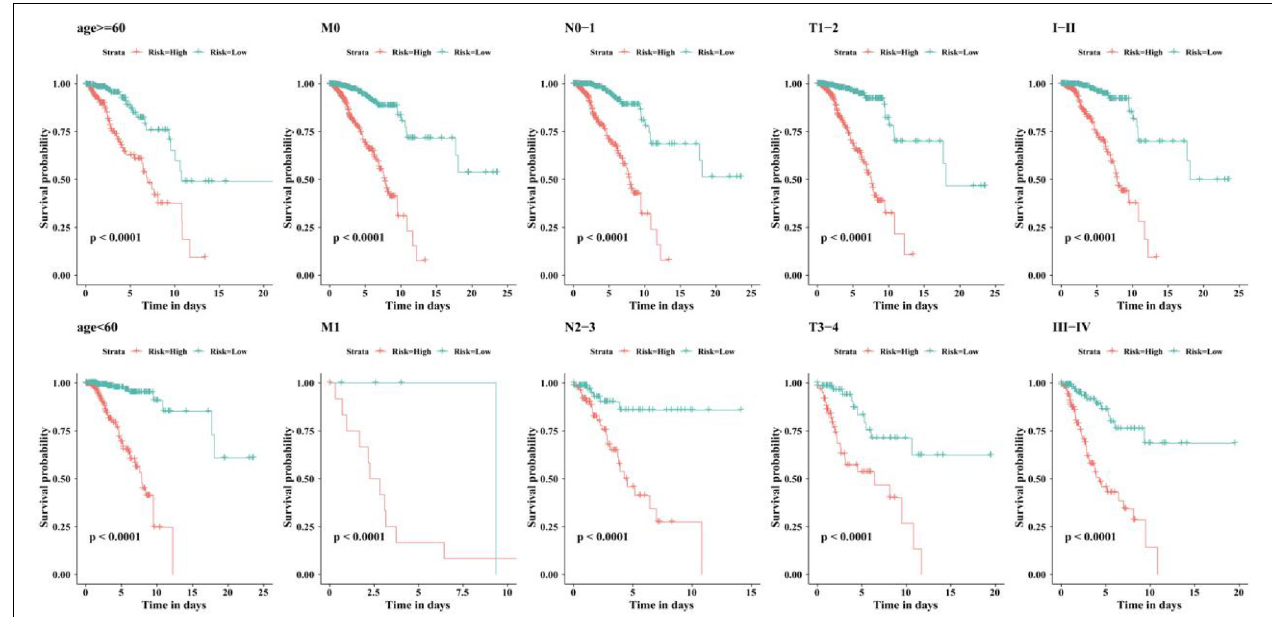
FIGURE 5 | Kaplan-Meier survival curves of BC patients in different clinical